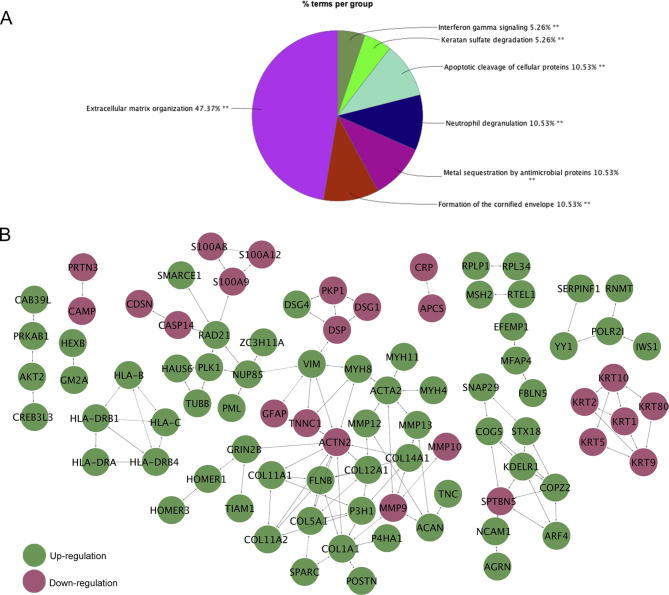
Pathway analysis of the differentially-expressed proteins in tissue samplesThe 281 differentially-expressed proteins between HO− and HO+ tissue samples from the iTRAQ analysis were used as input for Cytoscape plugin, ReactomeFI, or ClueGO. A. Pie graph of the distribution for the non-redundant significant gene ontologies (two-sided hypergeometric test; **P < 0.05). B. Clusters of protein–protein interactions for the differentially-expressed proteins (red and green indicates downregulation and upregulation in HO+ samples, respectively). Within each cluster multiple pathways are represented because of the involvement of proteins in many biological processes.